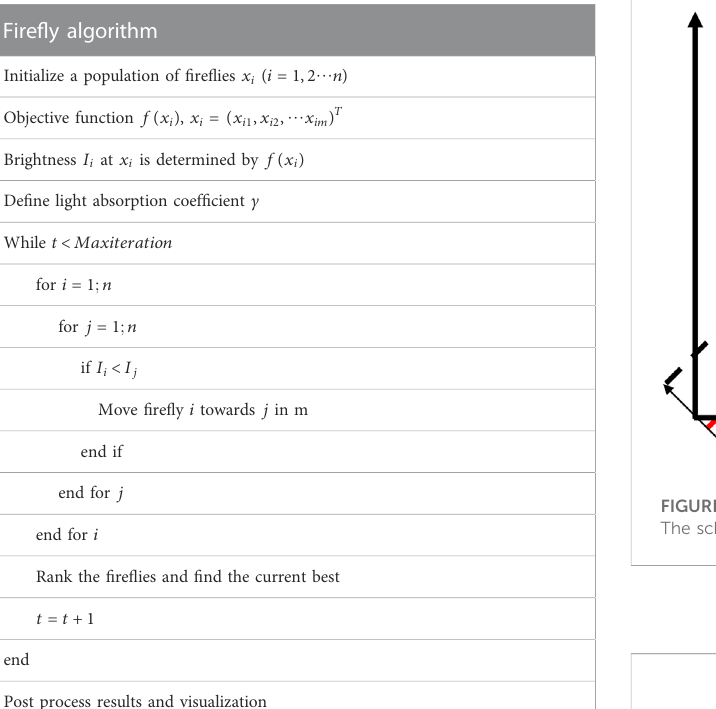
TABLE 2 The code of FA. Fire fl y algorithm